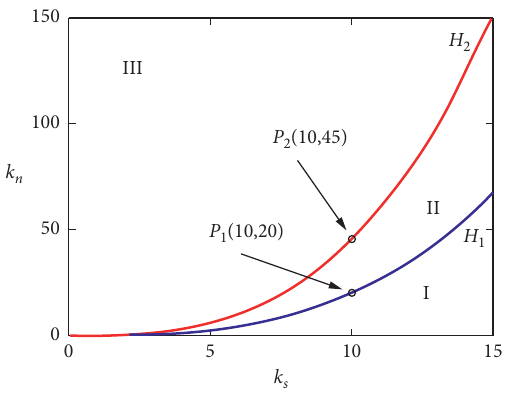
Figure 4: Transition sets in k